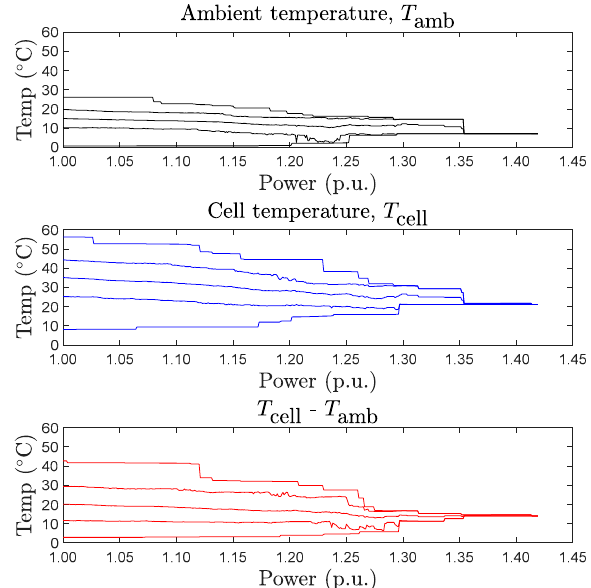
Figure 9. Maximum (100%), 90%, 50%, 10%, and minimum (0%) percentile values (from top to bottom) of the ambient temperature, the PV panel temperature, and the temperature difference between the PV panel and the ambient air during the overpower events, as a function of PV generator